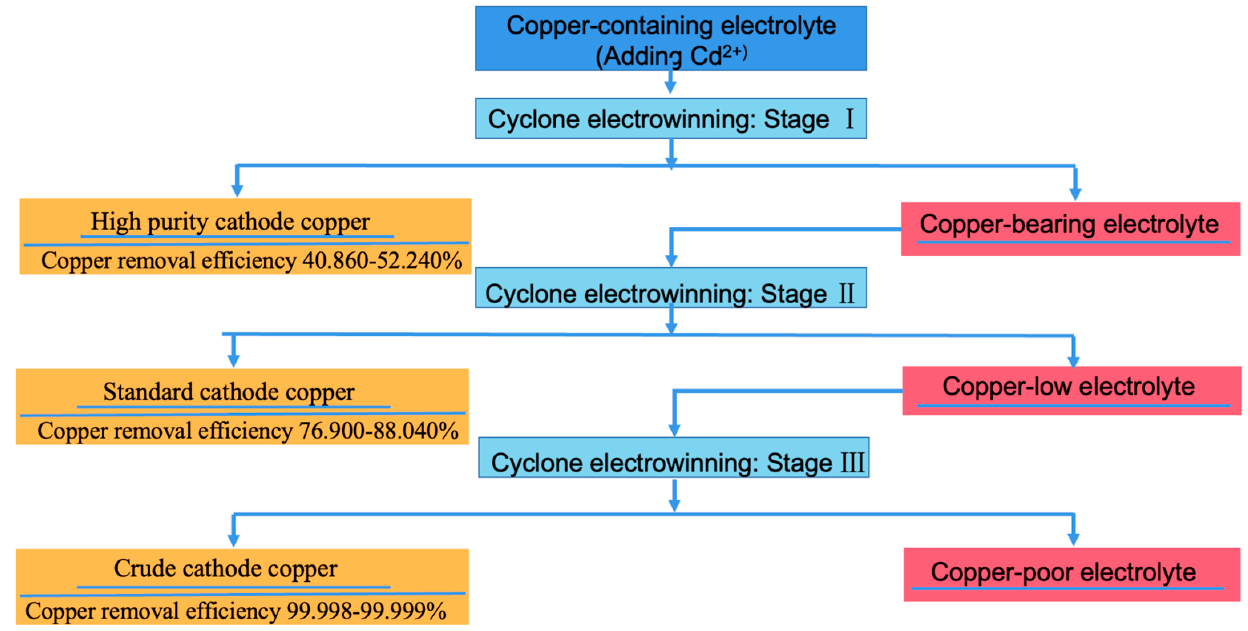
Figure 2. The flow chart of copper electrodeposition process in the simulated electrolyte with added cadmium ions.